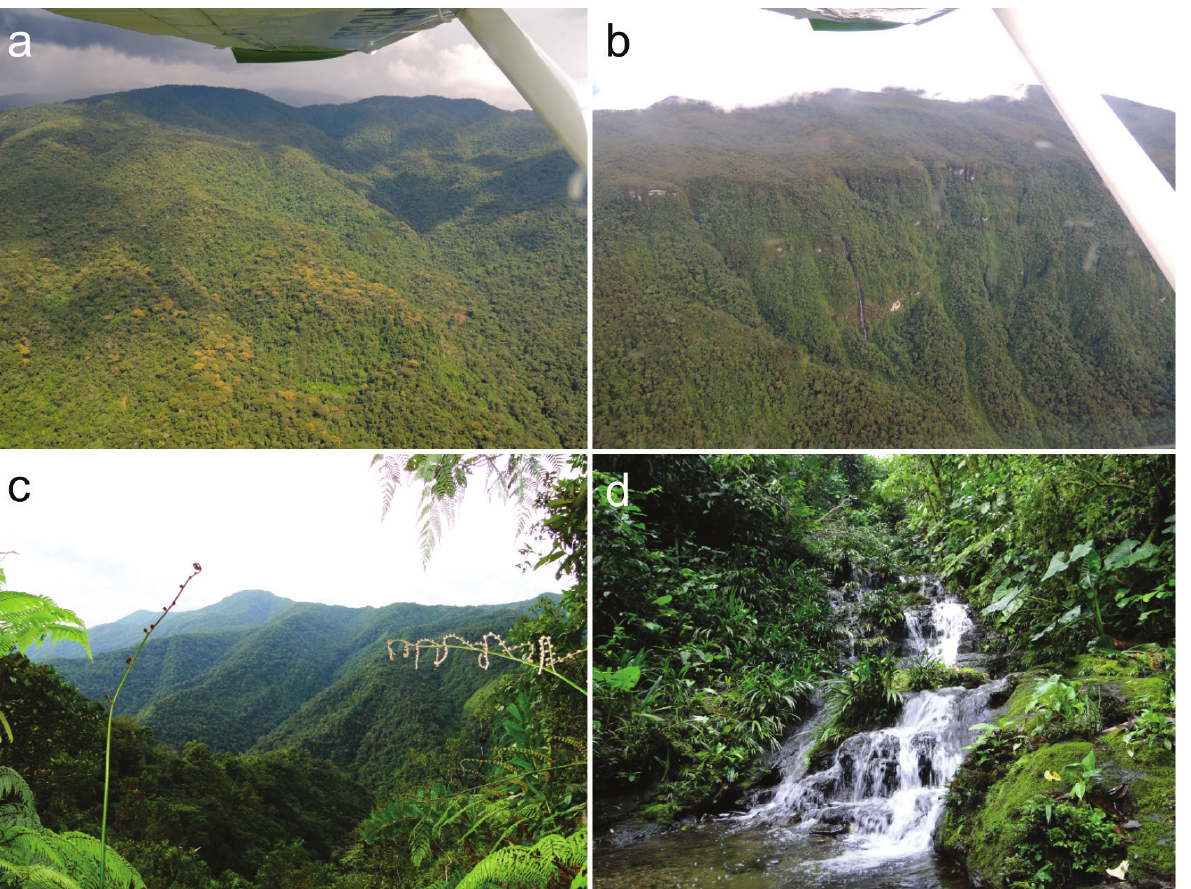
Figure 10. General landscape of the Cordillera de Kutukú (Ecuador), aerial survey in east-west orientation ( a, b ), photographs taken on August 26, 2017; field expedition in evergreen montane forest ( c, d ), and stream near the trapping site ( d ), photographs taken on September 8,